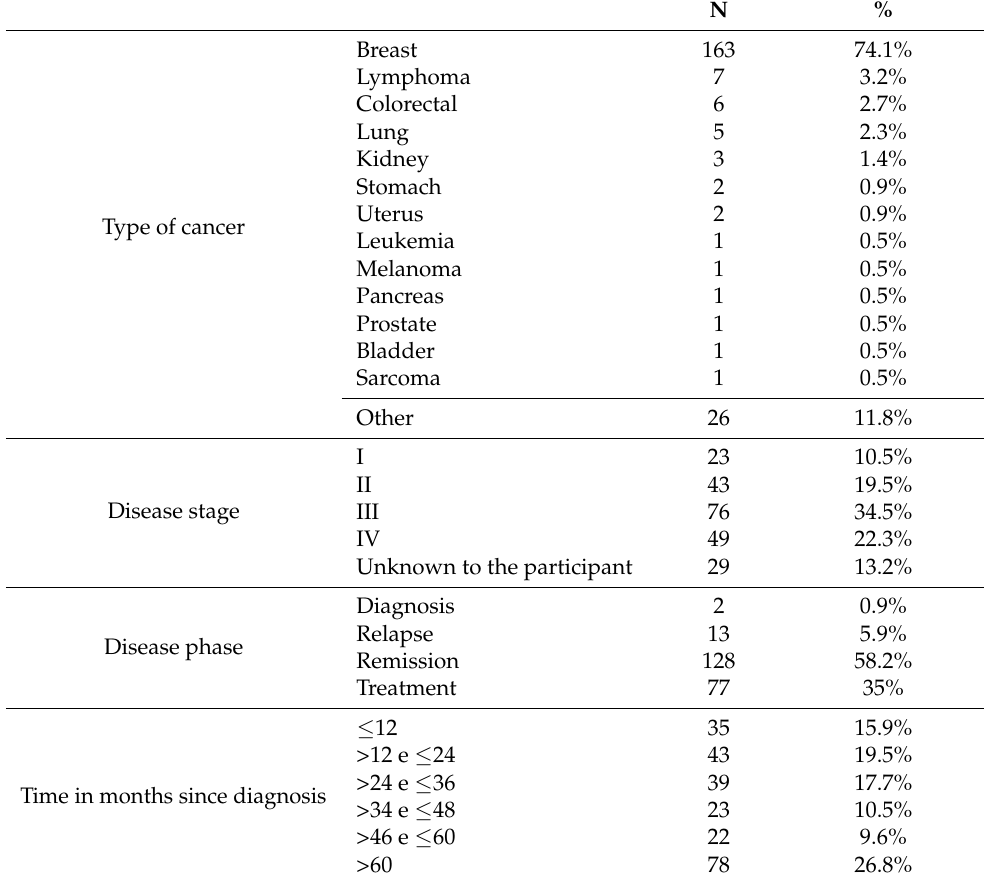
Table 1. Clinical characteristics of the sample (N =